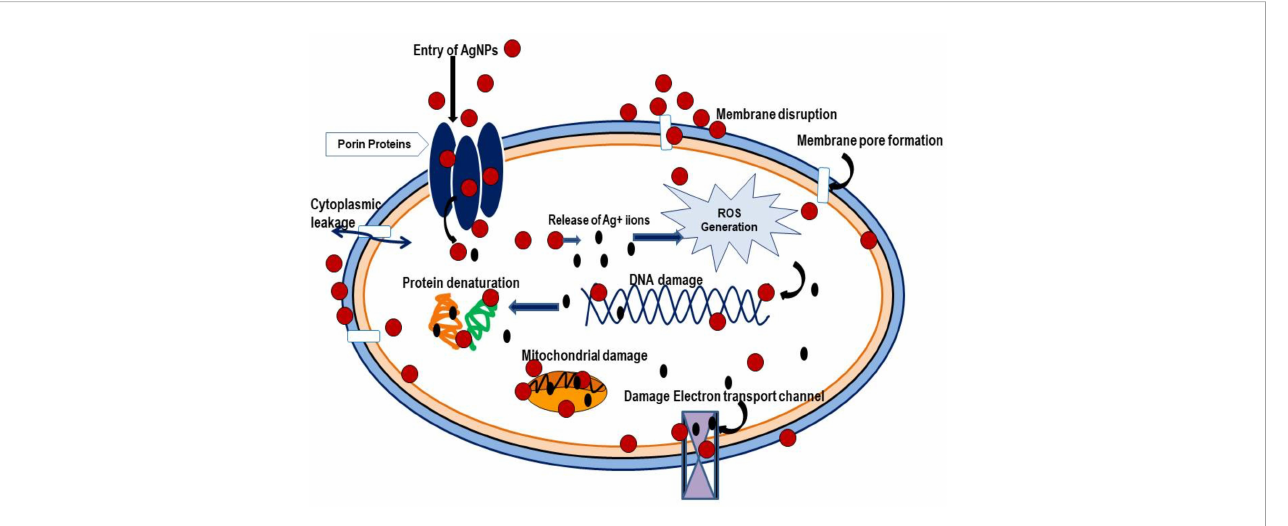
FIGURE 2 Mechanism of antimicrobial action of nanoparticles on